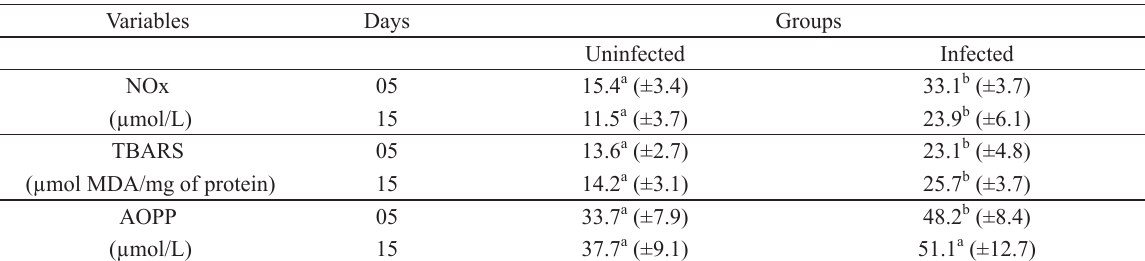
Mean and standard deviation of biomarkers of cellular injury in testicles of rats experimentally infected with Trypanosoma evansi . Serum concentrations of nitrite/nitrate (NO ), thiobarbituric acid reactive substances (TBARS) and x advanced oxidation protein products (AOPP) evaluated in the testicles of rats infected with T. evansi on days 5 and 15 post-infection.